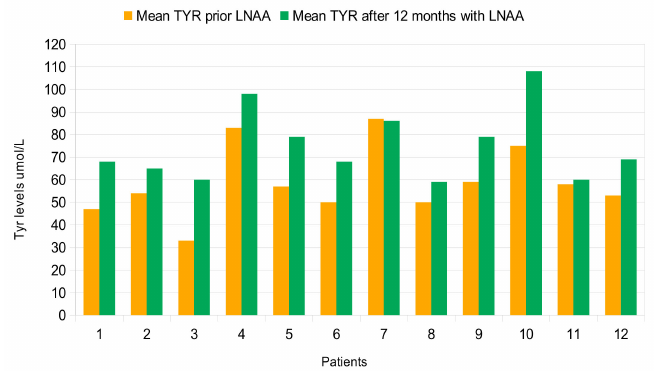
Figure 2. Mean Tyr levels 12 months prior and after LNAA introduction for each patient.